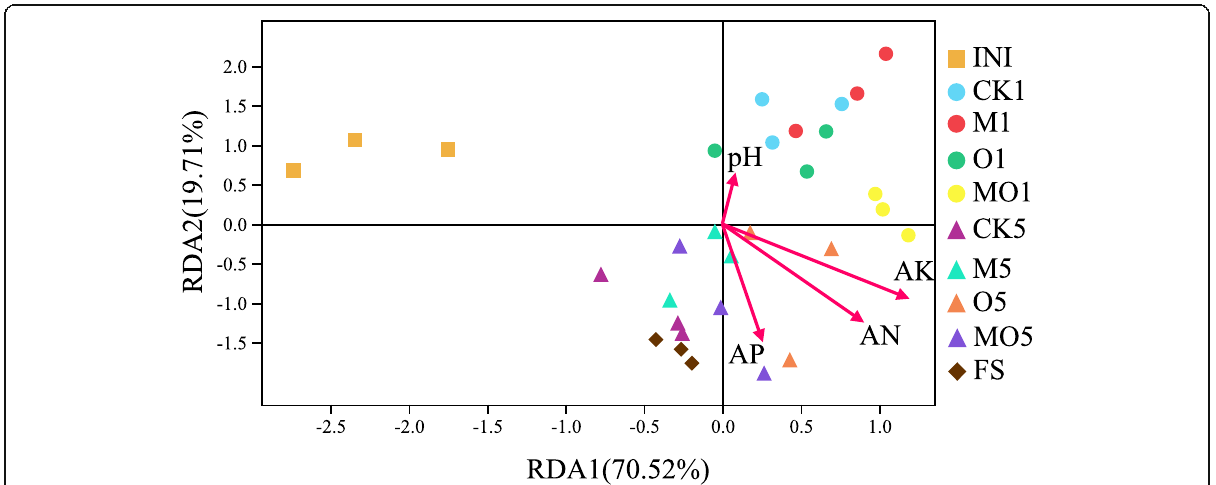
Fig. 5 Redundancy analysis (RDA) showing relationships between microbial communities and selected soil properties. The environmental factors, various fertilization, and reclamation time are indicated by red arrows, different colors, and shapes,